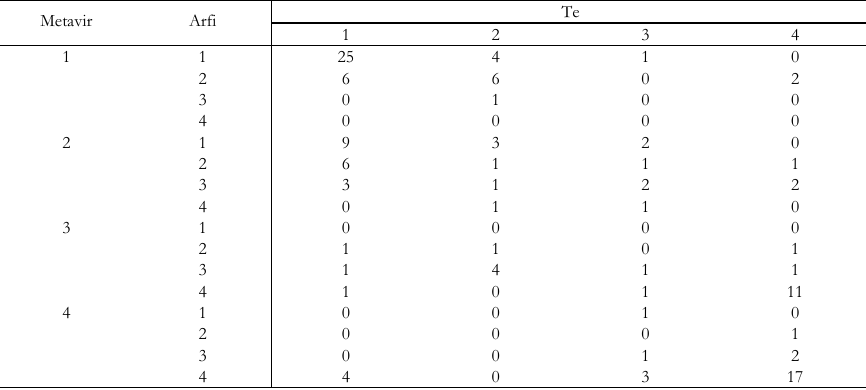
Three-way contingency table of patients according Metavir (i), Arfi (j) and Te